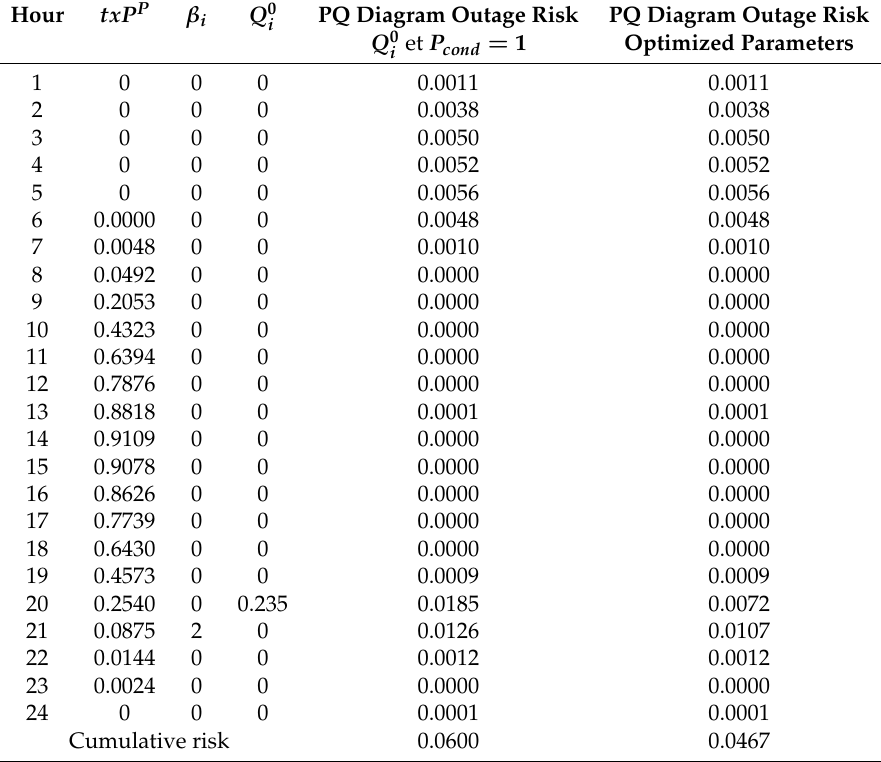
Table 2. DG optimized parameters.